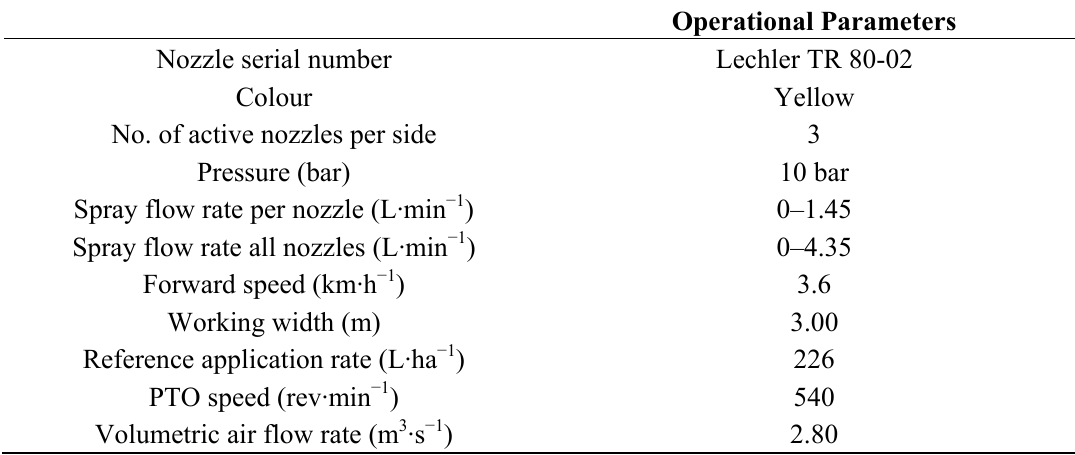
Table 2. Operational parameters during